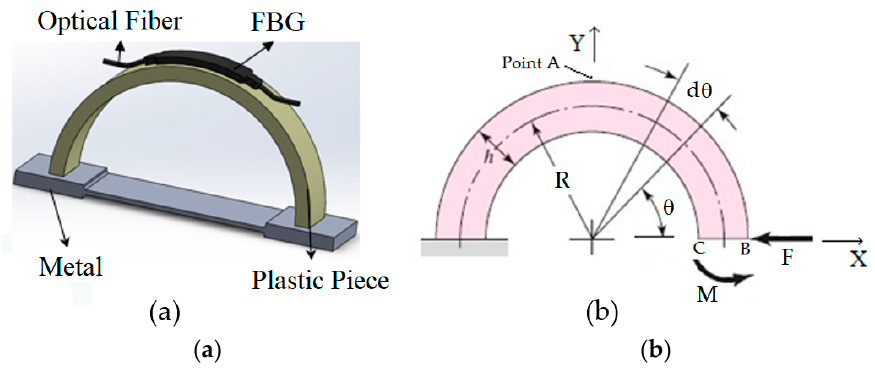
Figure 4. ( a ) Assembled sensor. ( b ) Boundary conditions.